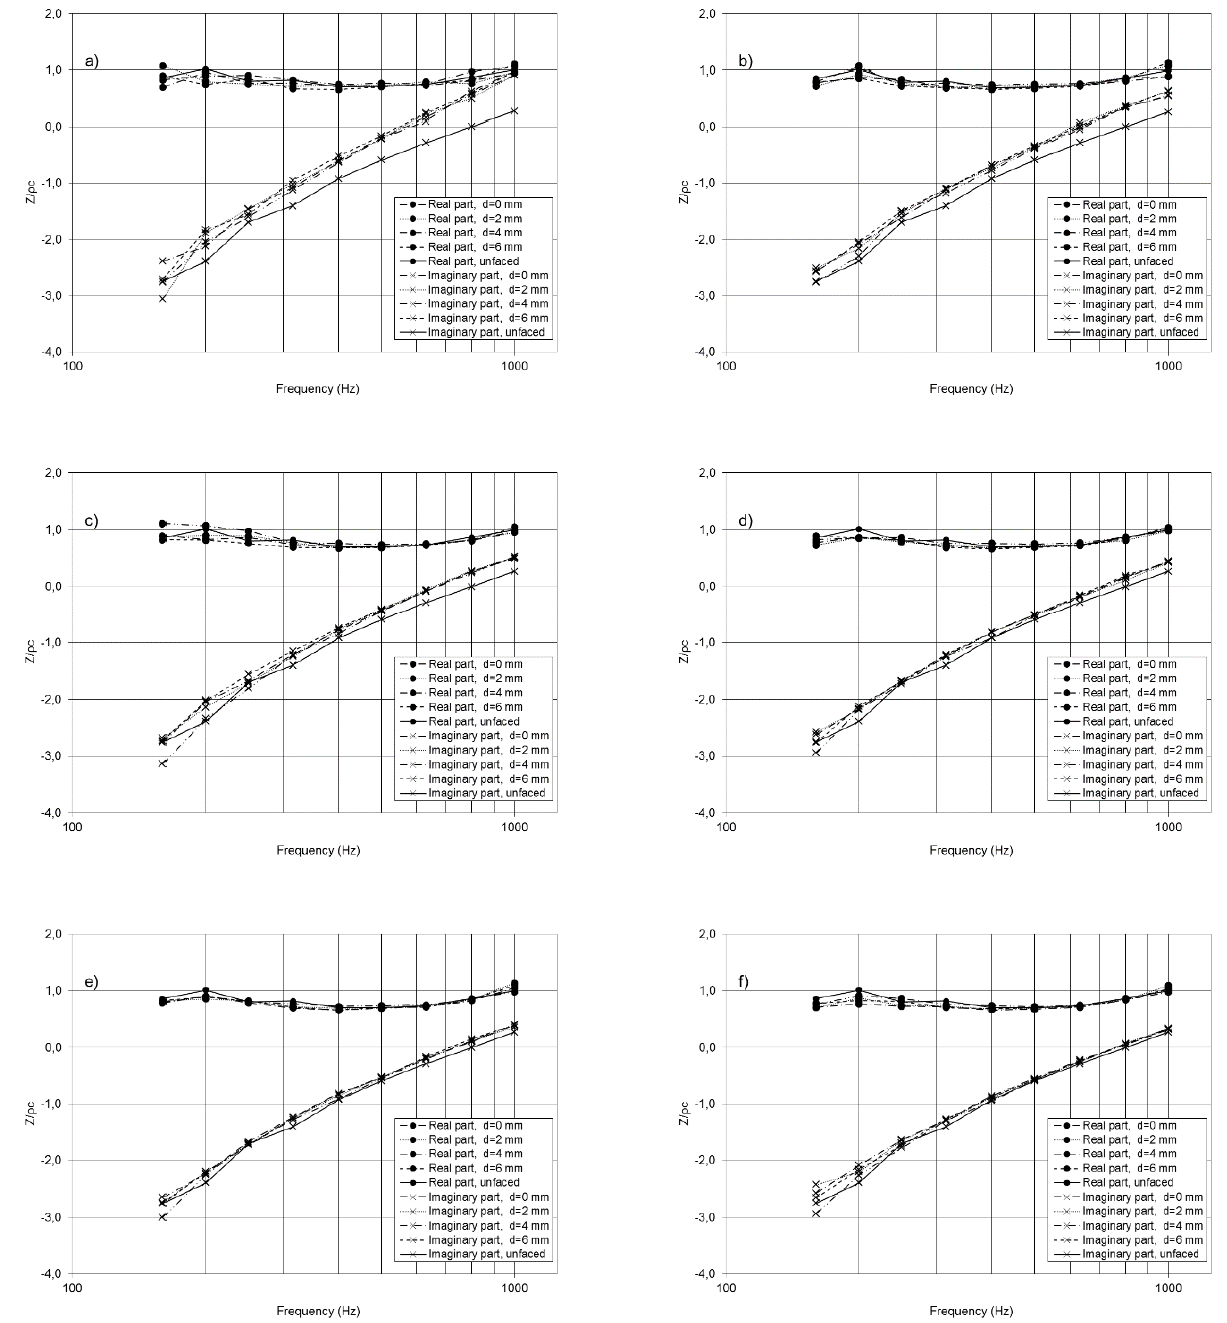
Figure 10: Normalized acoustic impedance curves for different air gaps, d, between the perforation and the absorbing material: a) σ = 4.9%; b) σ = 7.7%; c) σ = 10 %; d) σ = 15%; e) σ = 20%; f) σ =